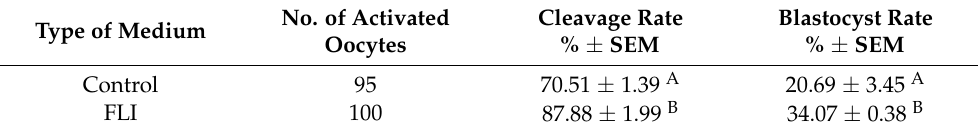
Table 4. Development of porcine oocytes cultured in control and FLI medium after parthenogenetic activation. Type of